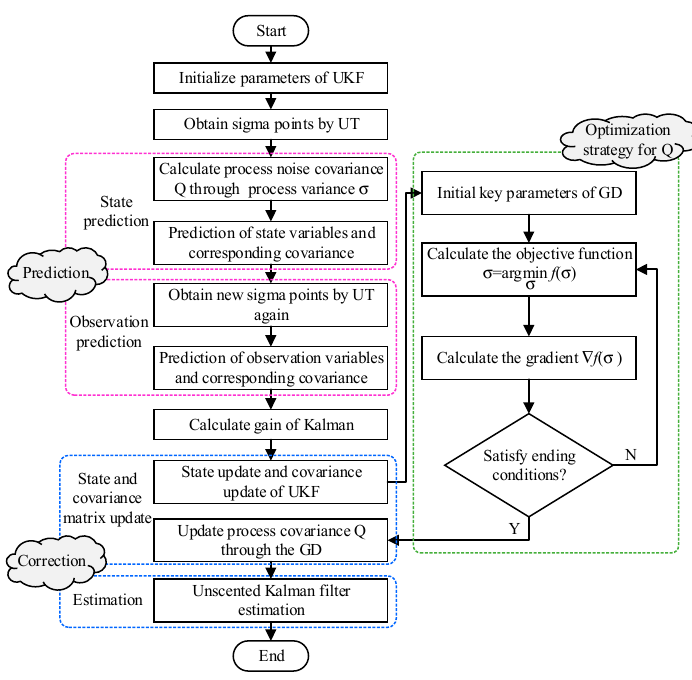
Figure 4. The flowchart of the proposed gradient descent algorithm-optimized quaternion-based unscented Kalman filter.